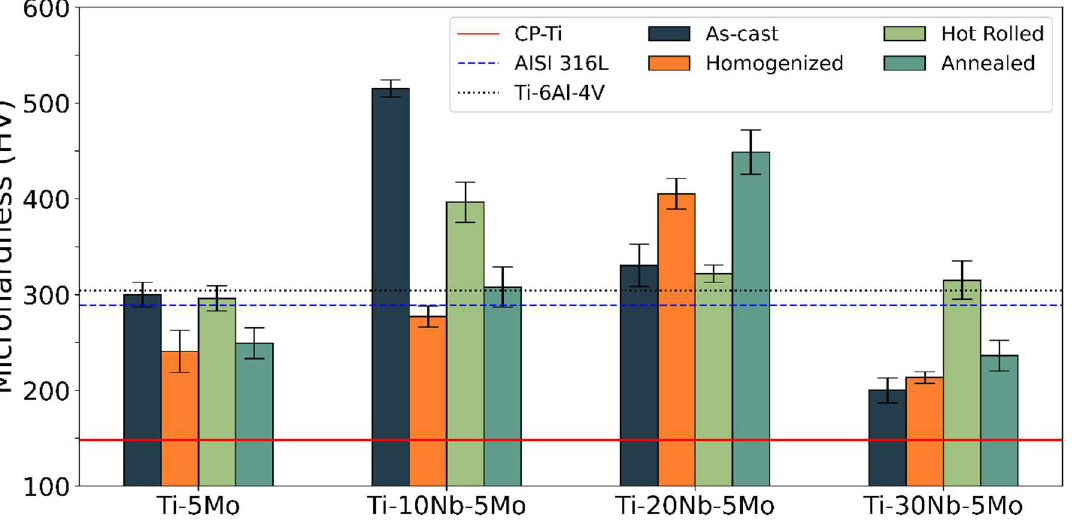
Figure 7. Vickers microhardness of the Ti-xNb-5Mo samples as a function of thermomechanical processing.